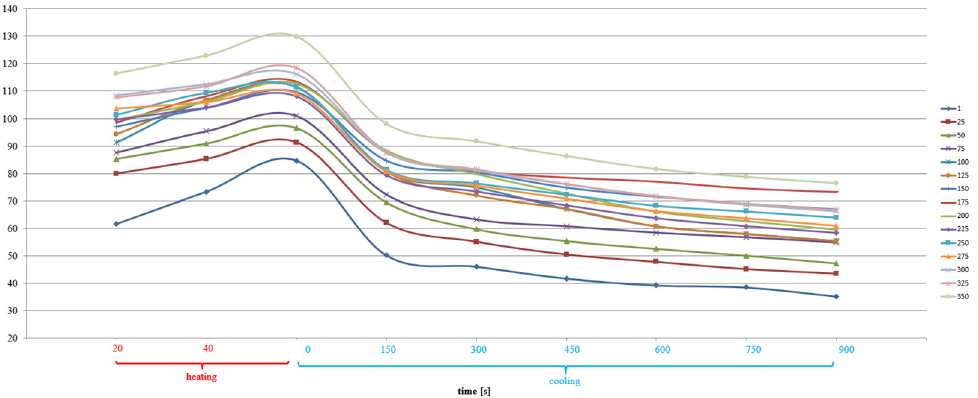
Figure 11. Change of the average temperature of CC-1 concrete as a function of heating and cooling time after a varied number of thermal cycles.